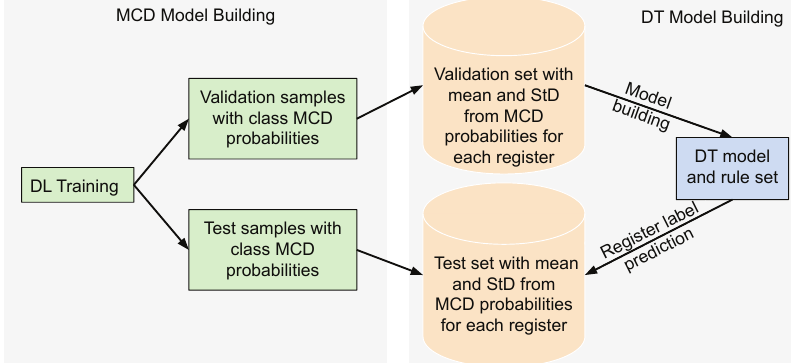
Figure 3. Flowchart of the proposed DL-MCD-DT learning: DL training of saccades with MCD, statistical feature extraction from groups in validation registers, DT model construction and classification and rules on the test